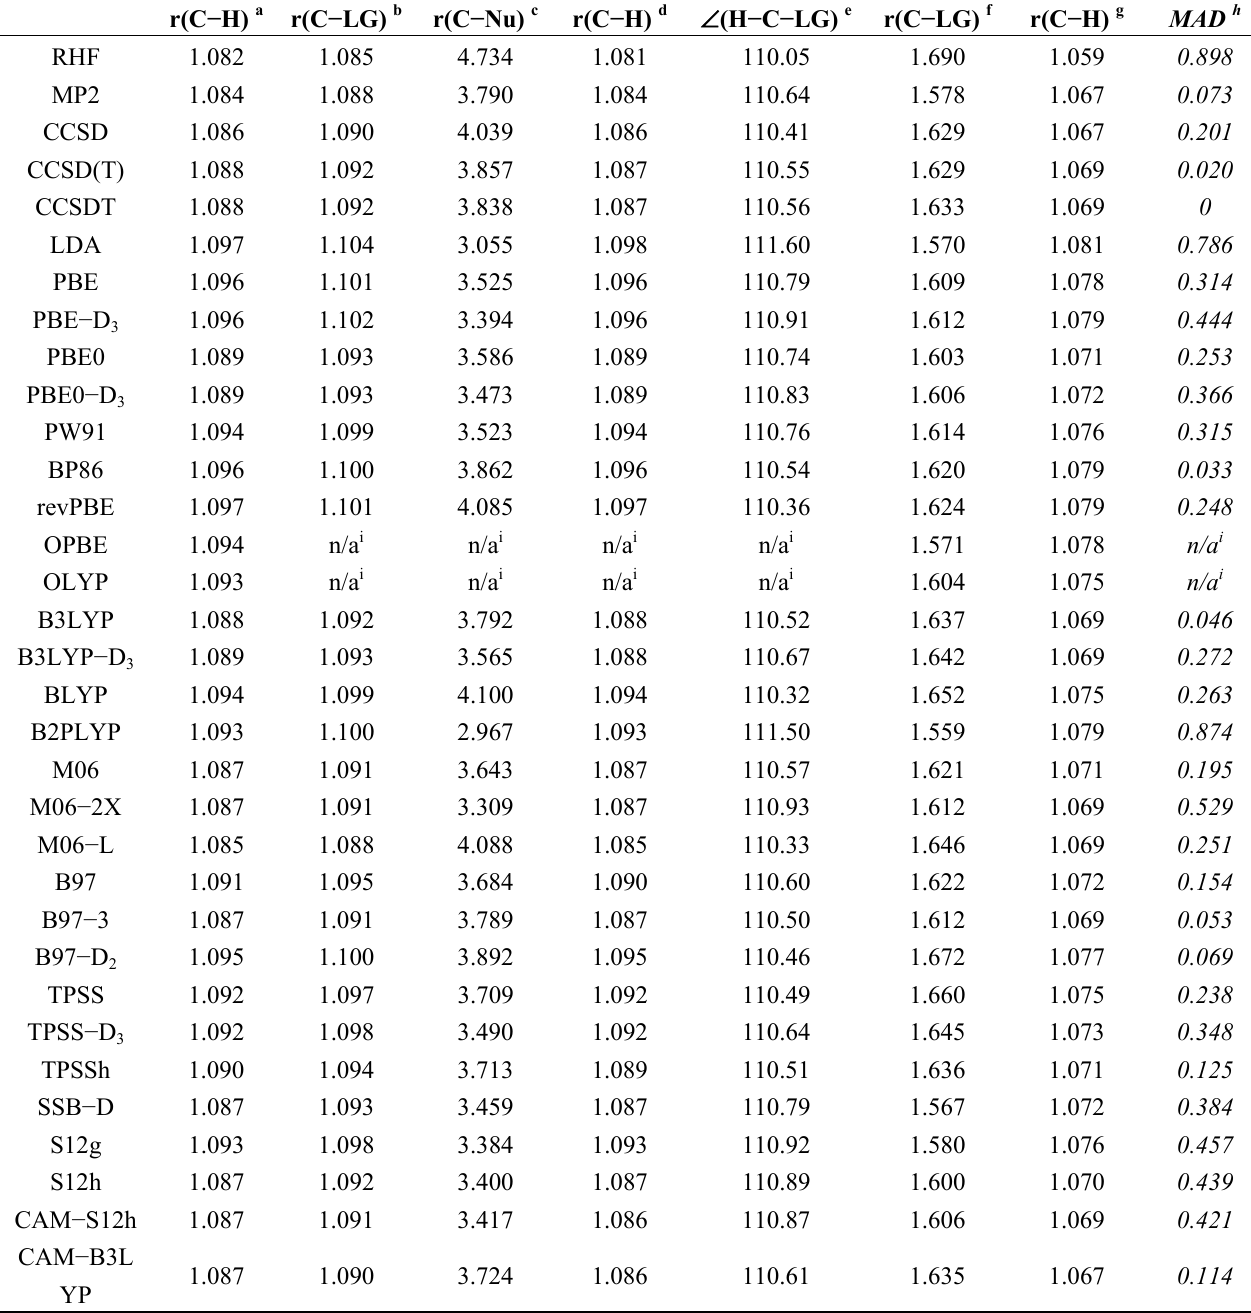
Table 2. Structural parameters (Å, °) for stationary points, obtained with atz basis